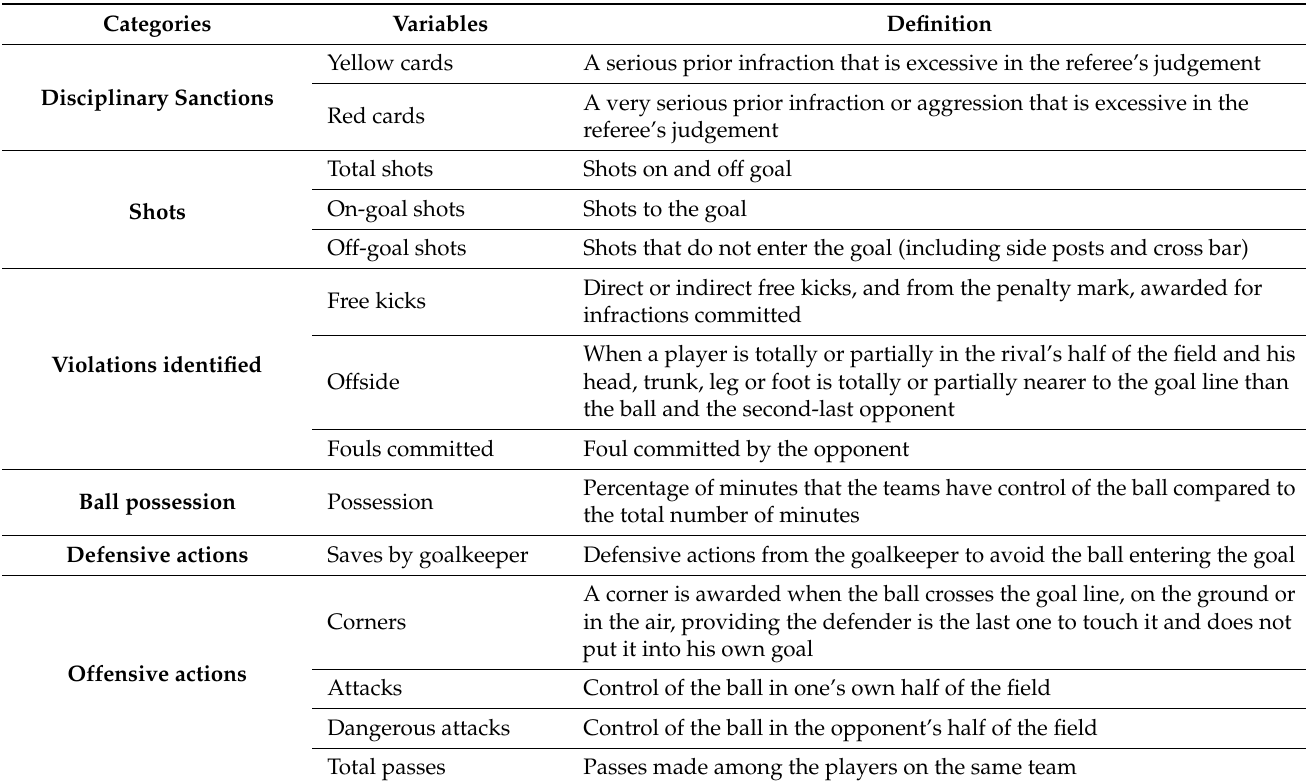
Table 1. Study dependent